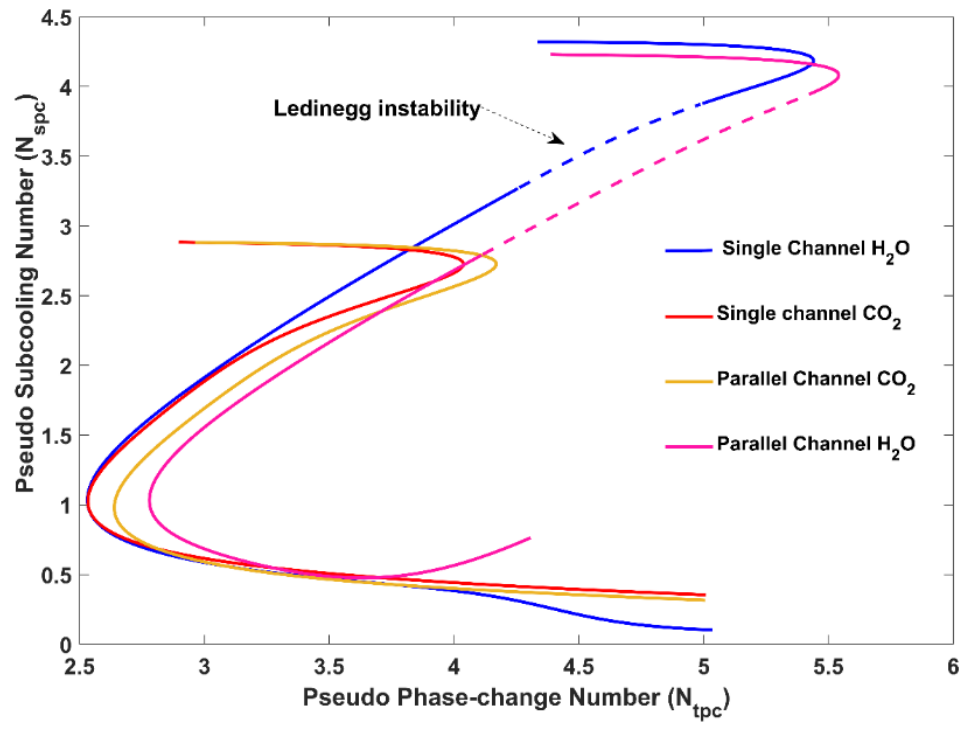
Figure 2. Stability threshold comparison at different working fluids for single and parallel channel systems.